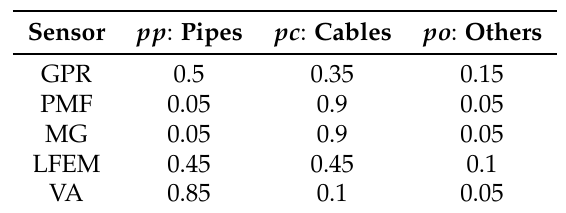
Figure 9. ( a ) Enlarged window of located utilities in the cyan window in Figure 8 when not using pp and pc ; the types of located utilities cannot be estimated, and the cable segment and pipe segment that are close to each other cannot be separated. ( b ) The located utilities after using pp and pc , the cable and pipe, which are close to each other, can be separated successfully. Table 2. The probability of an extracted hypothesized detection being from a pipe or a cable for different sensors: pp , the probability of a hypothesized detection to be a pipe; pc , the probability of a hypothesized detection to be a cable; po , the probability of a hypothesized detection to be other types of